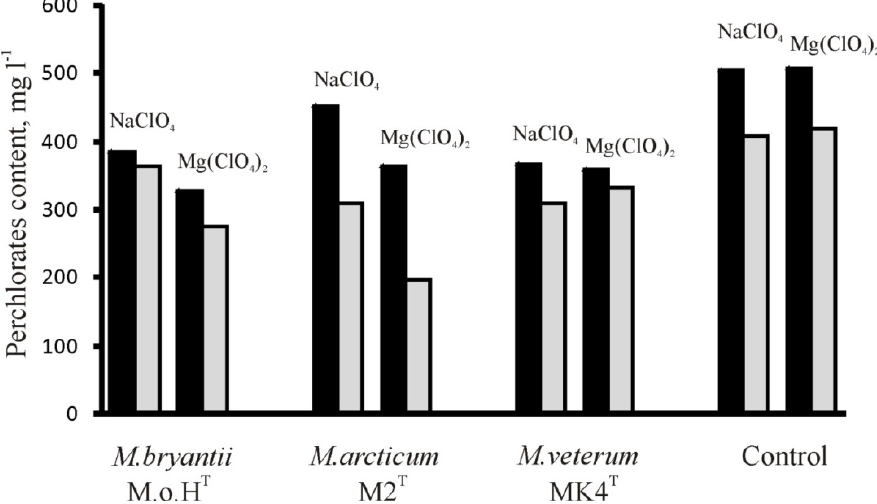
Figure 4. The perchlorates content during the cultivation of hydrogen-consuming methanogens. Black bars—perchlorate concentration in the medium at the initial point; gray bars—the perchlorate concentration after nine days of growth. The control was MB medium supplemented with perchlorate